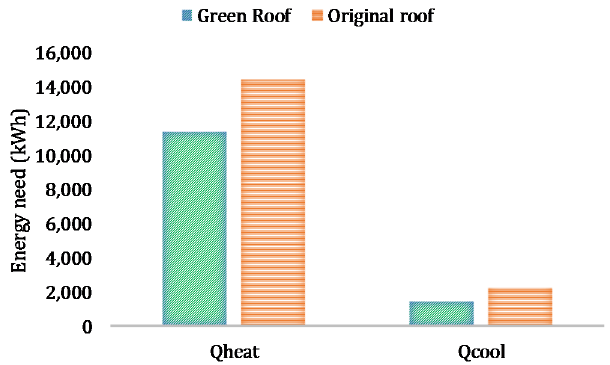
Figure 10. Comparison between annual heating and cooling energy needs. Table 2. Comparison among heating and cooling energy needs in different climatic conditions. Rome